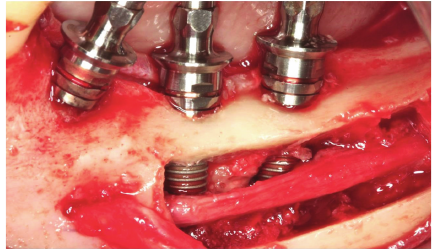
Figure 20: Suture.